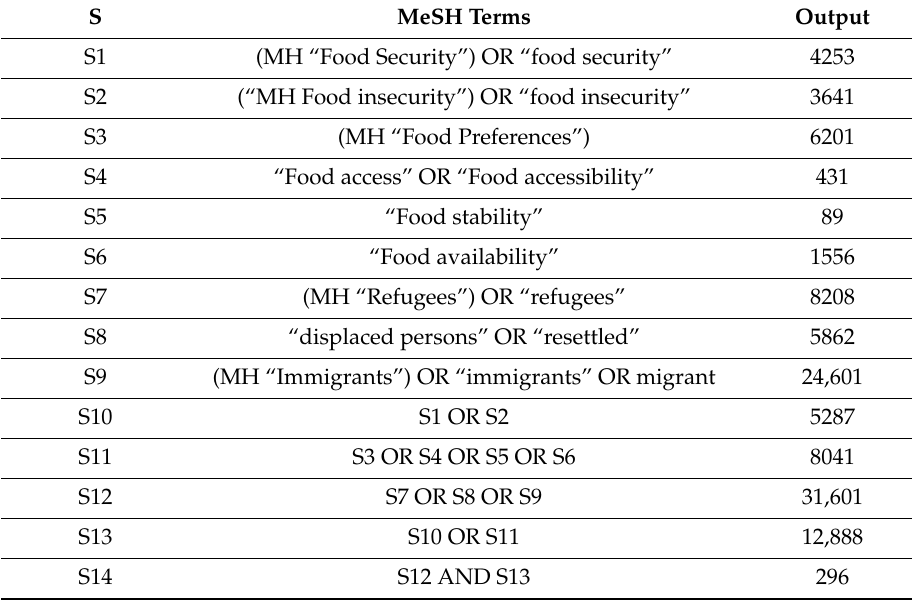
Table A2. CINAHL search–Ovid interface.